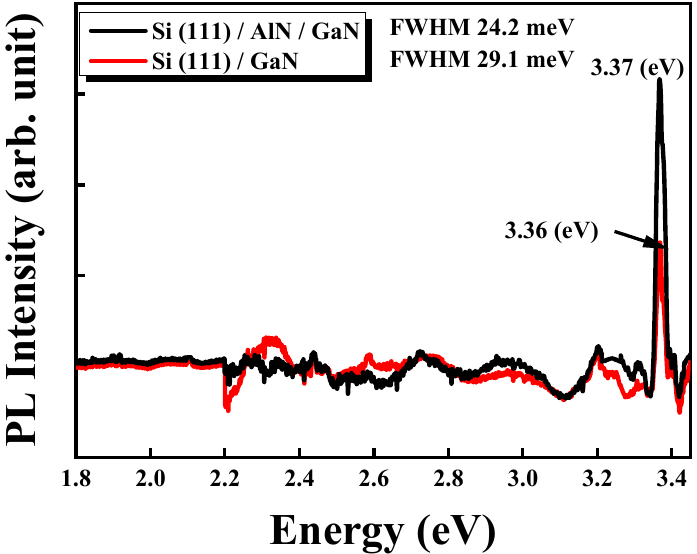
Figure 10. Photoluminescence spectra for Si/GaN and Si/AlN/GaN.